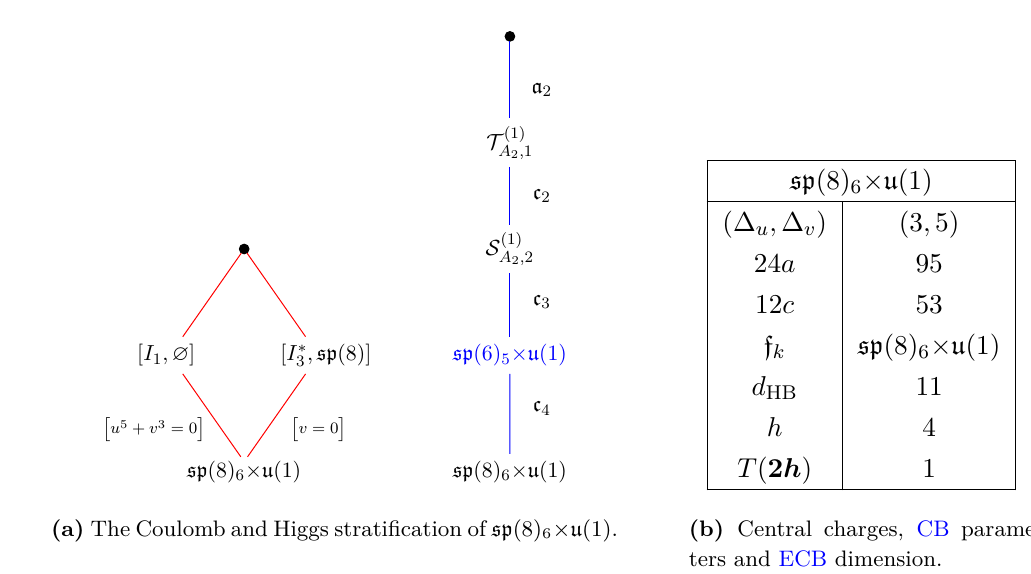
Figure 31. Information about the sp (8) 6 × u (1)